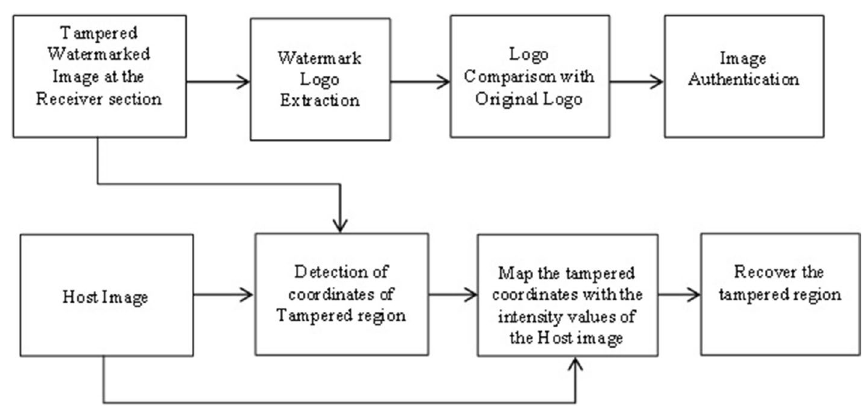
Fig. 7 Image authentication and recovery from tampered watermarked